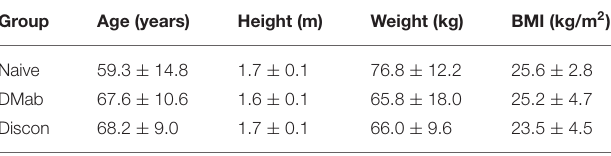
TABLE 1 | Patient characteristics evaluated based on medical records.